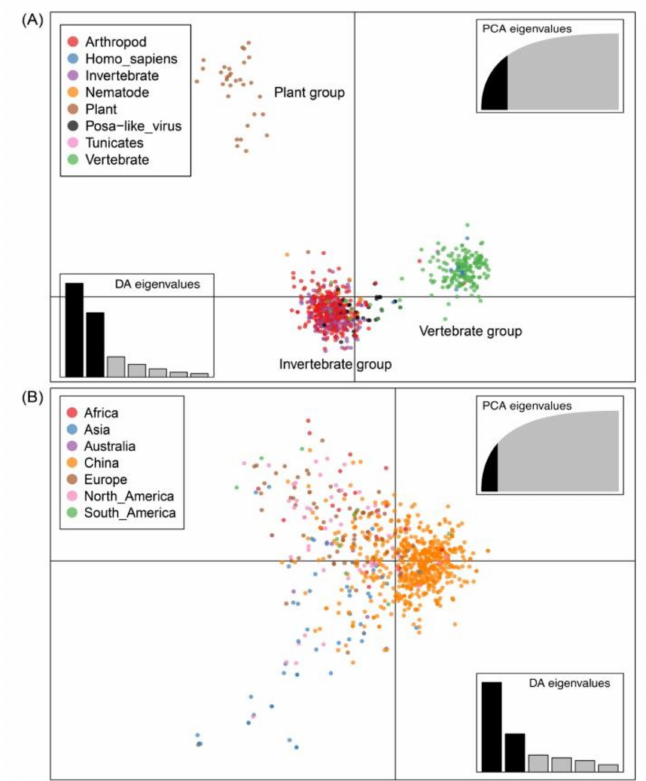
Figure 5. The first two principal components of the genomic sequences of Picornavirales , with the hosts and available sample locations used as the prior groups. Eigenvalues of the analysis (PCA and DA) are displayed in the inset, along which the black modules represent the dimensions retained and the gray modules show the dimensions eliminated in the datasets. Groups are shown in di ff erent colors, with dots representing individual strains. ( A ) The scatterplot using the host information as a prior cluster. ( B ) The scatterplot using the location information as a prior cluster. PCA, principal component analysis; DA, discriminant